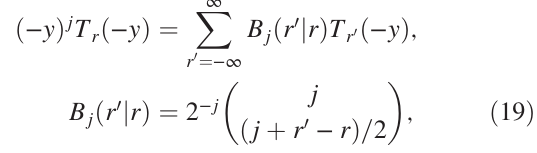
FIG. 3. Schematic picture of the random walk. The exponential x Þ with the function e − b ð 1 þ y Þ = 2 is given by the expectation of T r b ð probability P ð r , as in Eq. (17). The probability P ð r is b Þ b Þ generated from the b -step random walk. In each step, the probability from r to r 0 is given by p ð r 0 j r Þ , which is a symmetric function around r . In the picture, we give the numerical plot of p ð r j 2 Þ , where the shape of p ð r j r 0 Þ does not depend on r 0